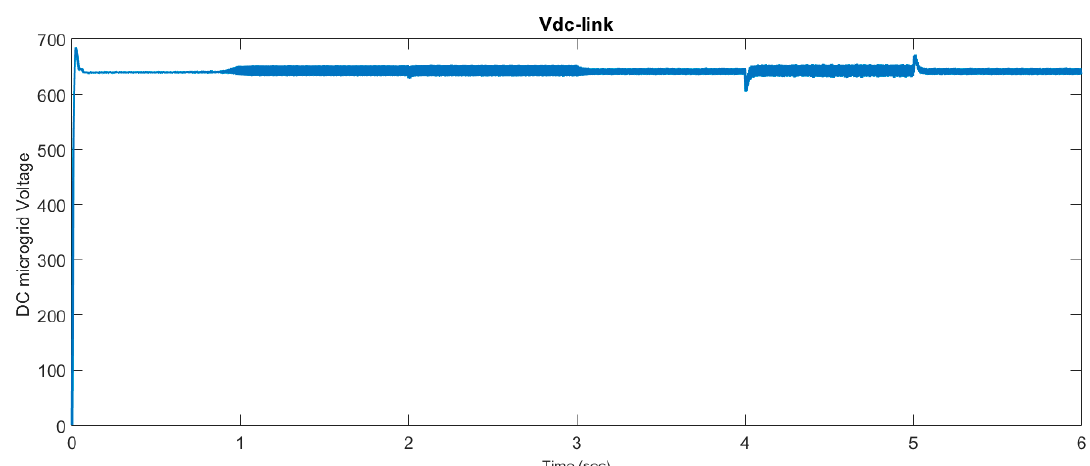
Figure 13. The Simulink model of the studied DC microgrid.